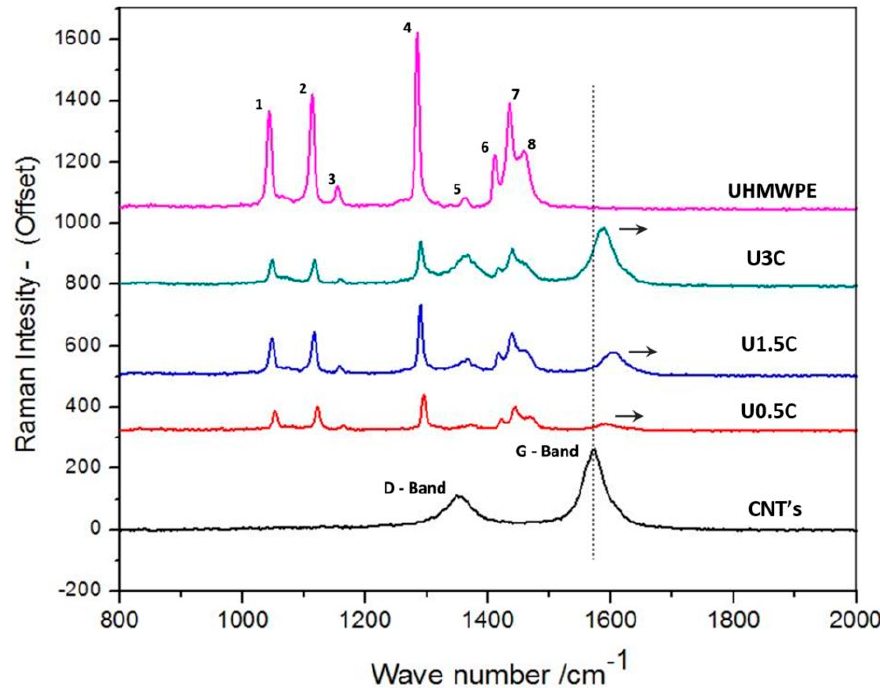
Figure 1. Raman spectroscopy peaks of pristine ultra-high molecular weight polyethylene (UHMWPE), UHMWPE reinforced with 0.5, 1.5, and 3 wt.% capacity carbon nanotubes (CNT’s).